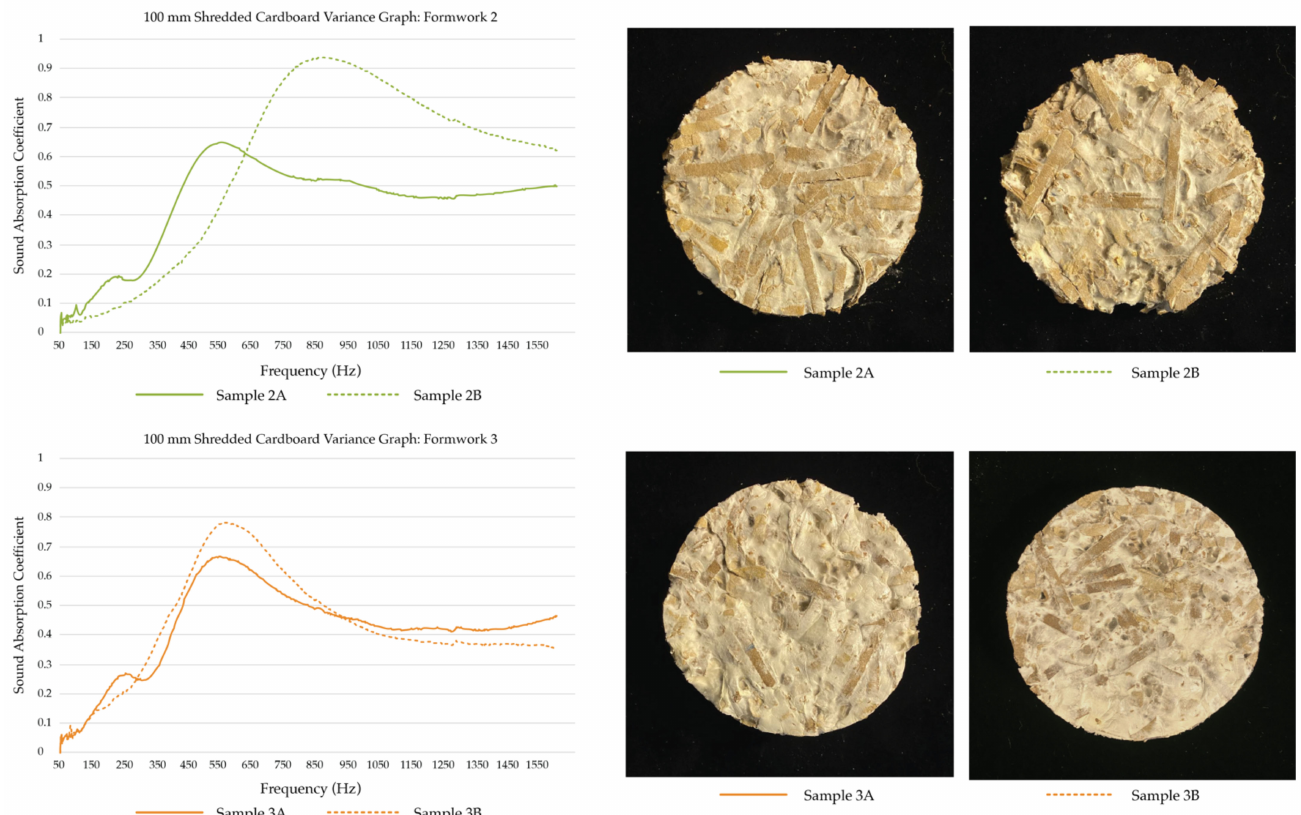
Figure 15. Sound Absorption Coefficient Graphs and the Shredded Cardboard Samples Tested. A visual inspection to compare surface texture and porosity with the respective material